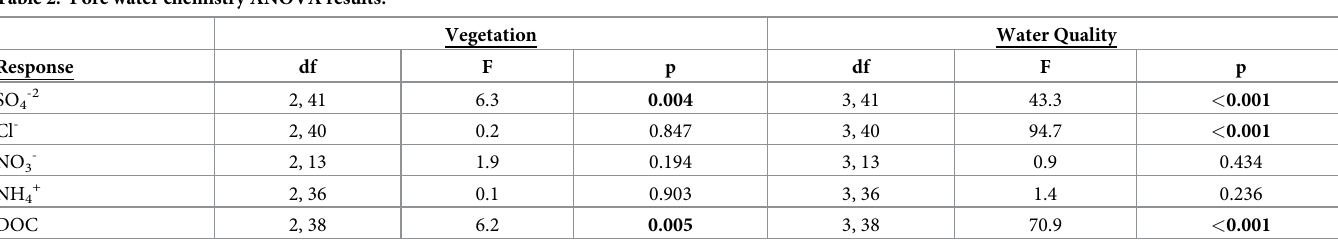
Table 2. Pore water chemistry ANOVA